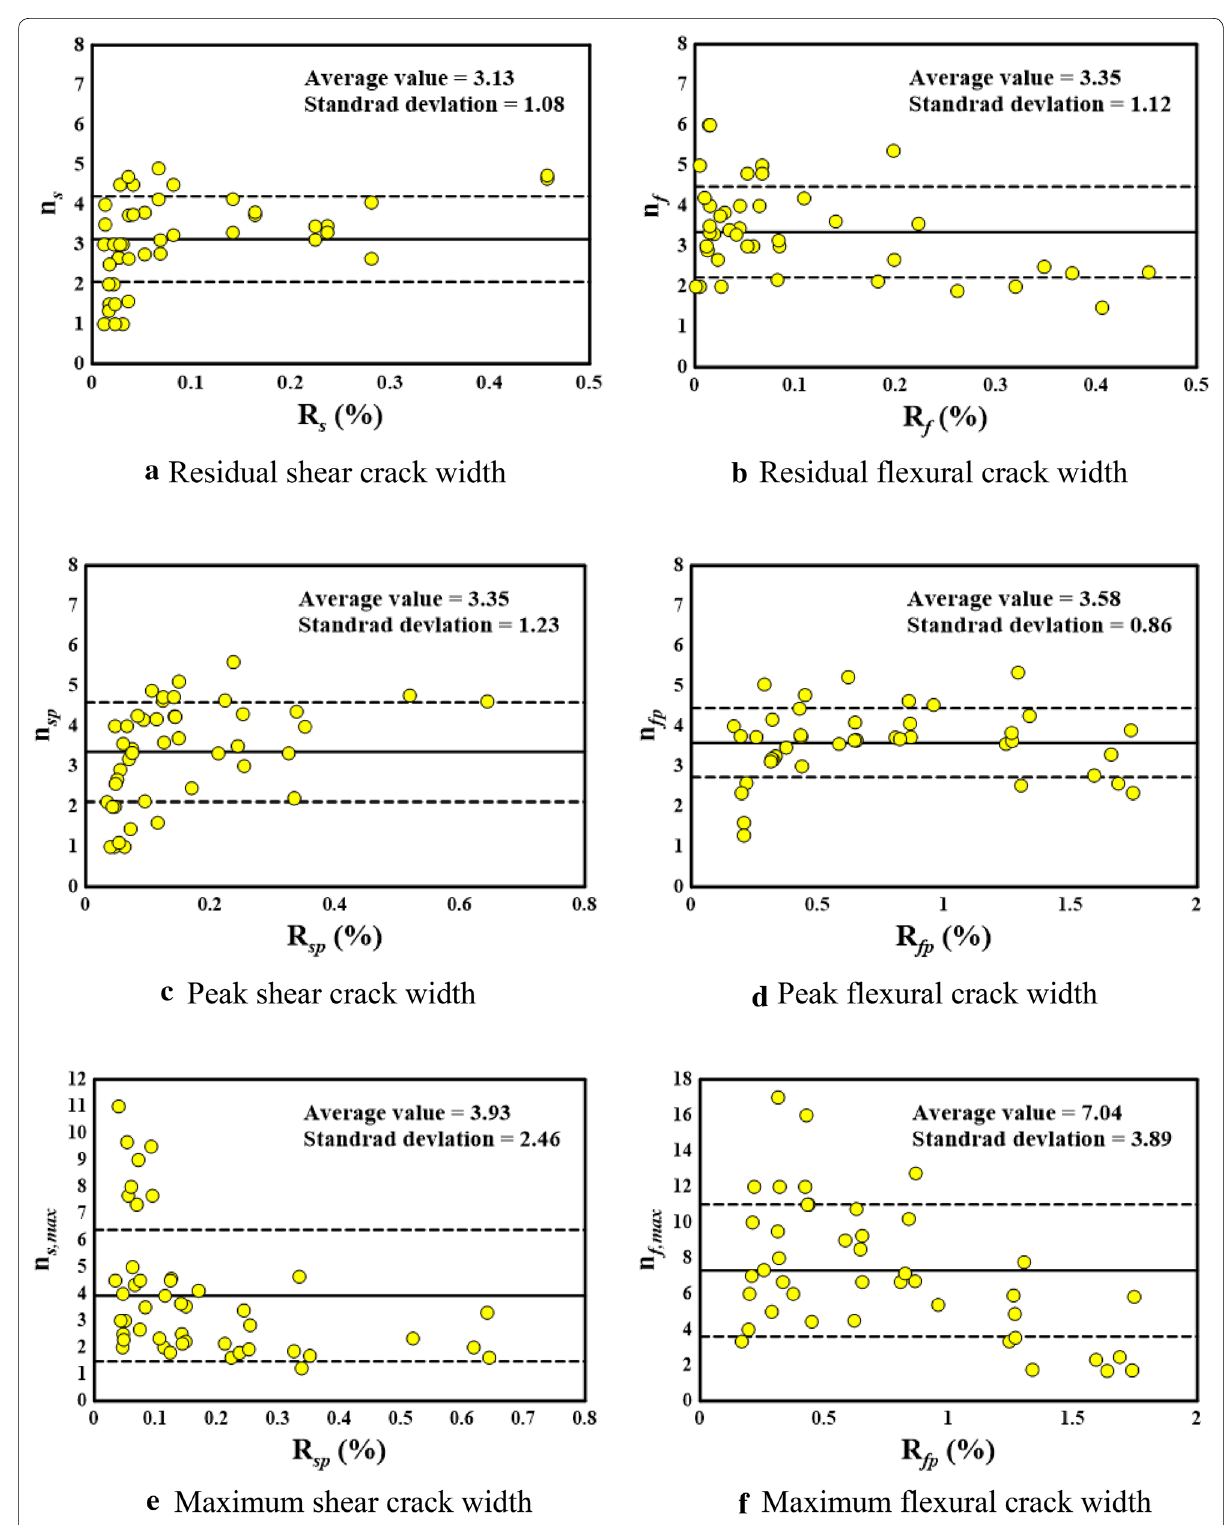
Fig. 13 Experimental values of n s , n sp , n s, max , n f , n pf , and n f,max